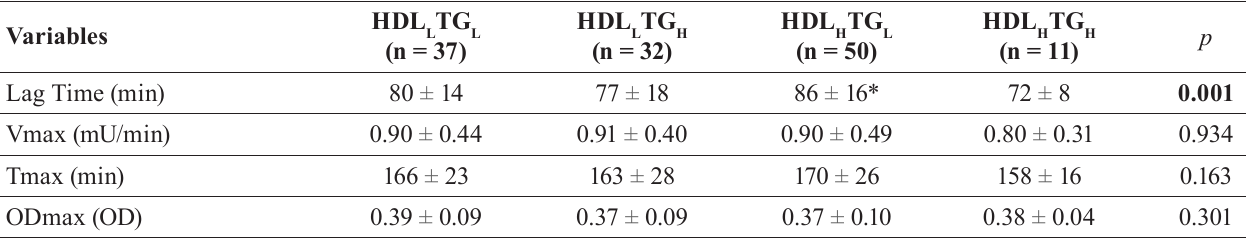
Variable were expressed as mean ± (standard deviation); Lag Time = time without lipid oxidation; Vmax = maximum rate of lipid oxidation; Tmax = time for the maximum rate of lipid oxidation; ODmax = maximum intensity of oxidized products. (*) Significant difference between groups ( p <